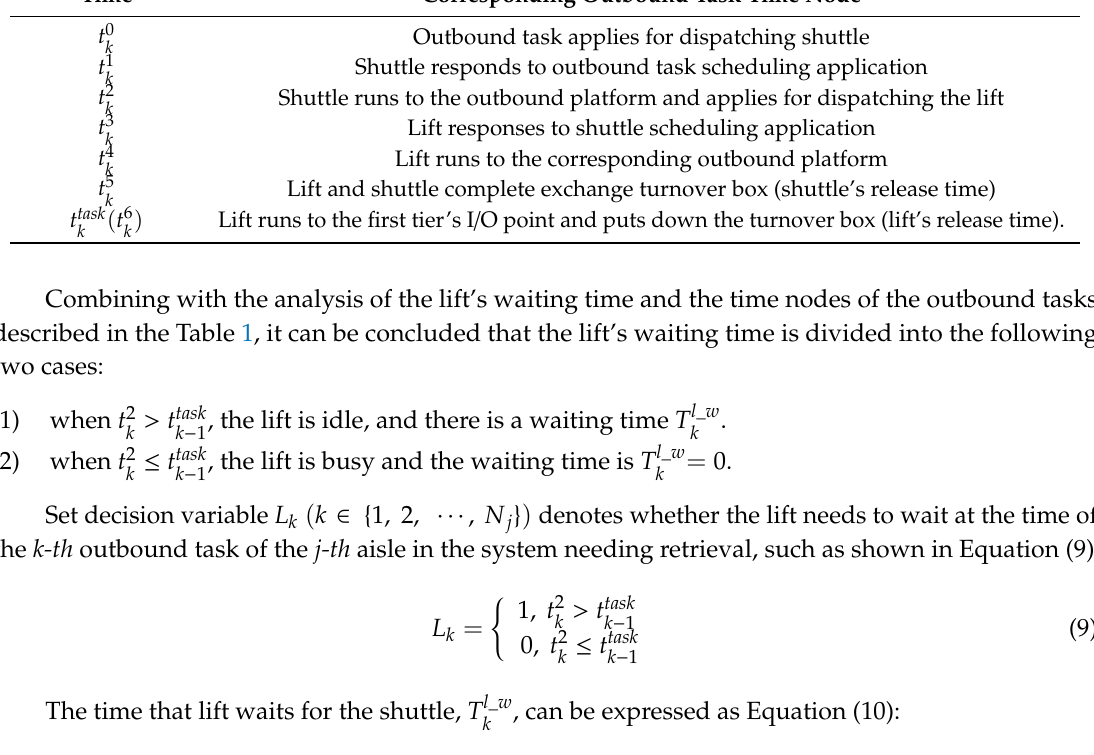
Table 1. Time nodes of the outbound task.